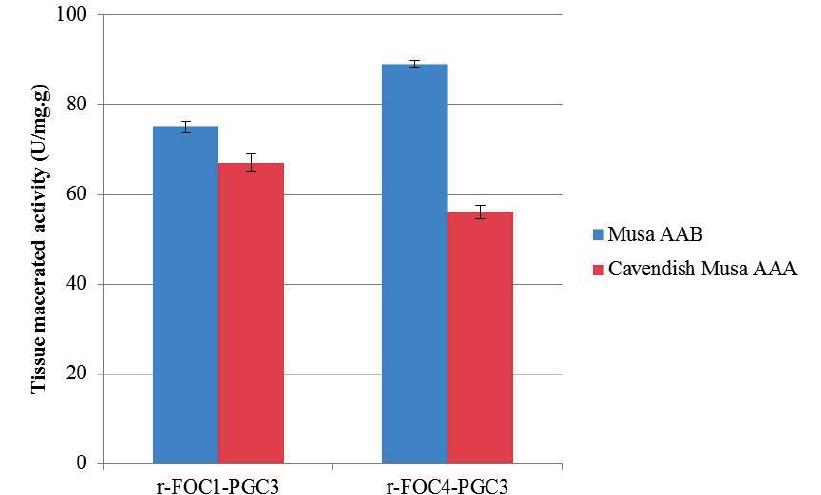
Figure 5. Enzyme maceration activity in banana tissue. 1 U of purified enzyme mixed with 1 mL of 50 mM sodium acetate buffer pH 4.5 was inoculated with sterilized banana tissues, and maceration was evaluated after 48 h at 50 °C. The same buffer without enzyme as negative control. The reducing sugar content was analyzed by the method of Somogyi in three